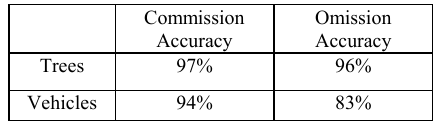
Table 3: classification performance for dataset